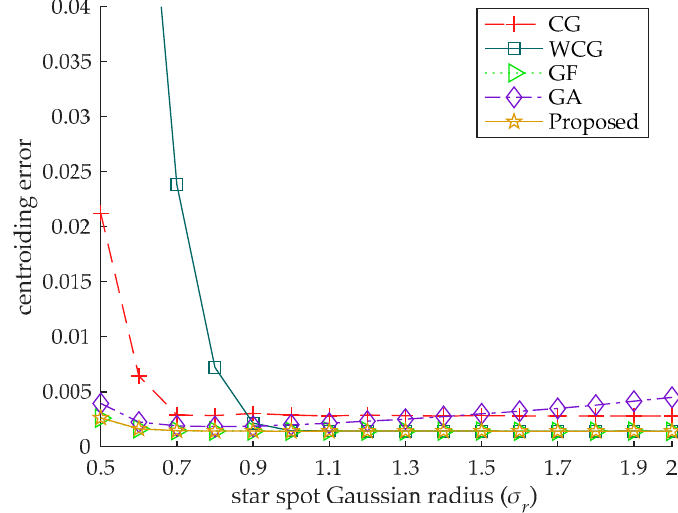
Figure 5. The centroiding error under different spot radius. The centroiding error of the proposed algorithm is almost the same as that of the GF under all the radius of the star spot, less than that of other algorithms.